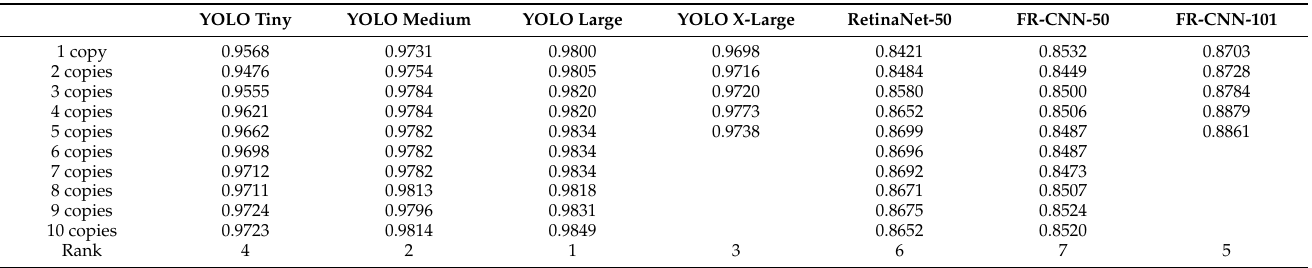
Table A2. AP values of ensembles built from individually trained copies of each detector type and